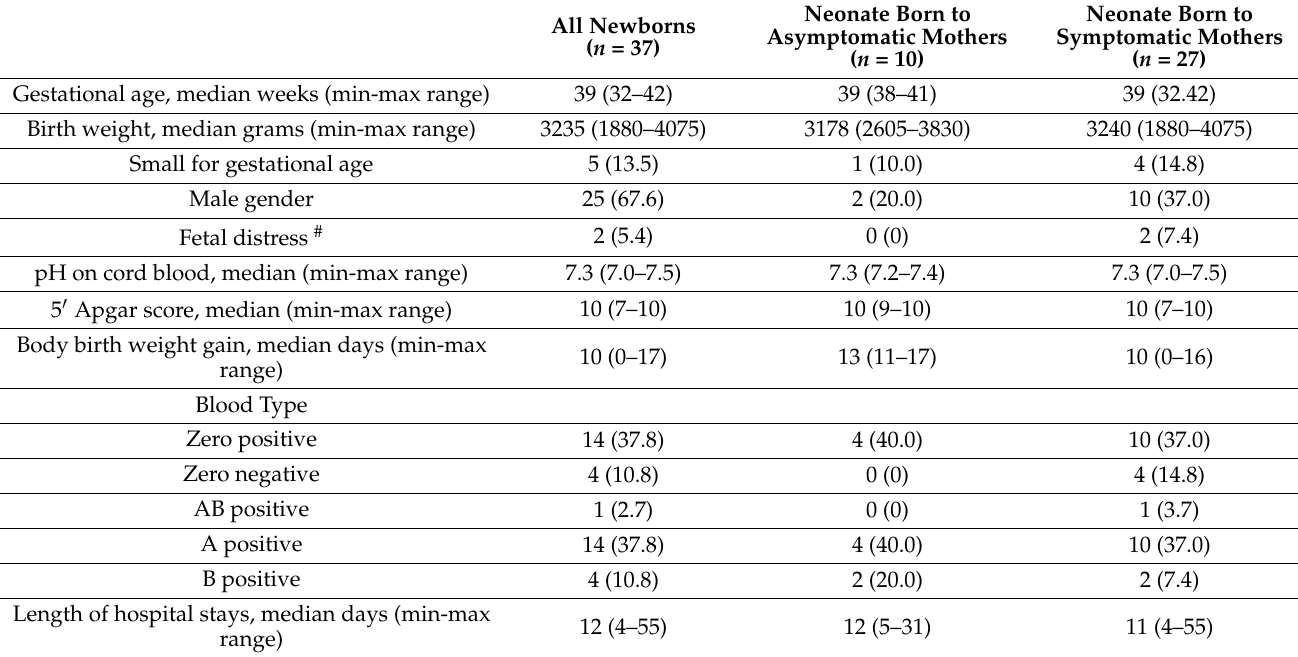
Table 3. Characteristics of newborns from mothers with confirmed SARS-CoV-2 infection at the delivery.